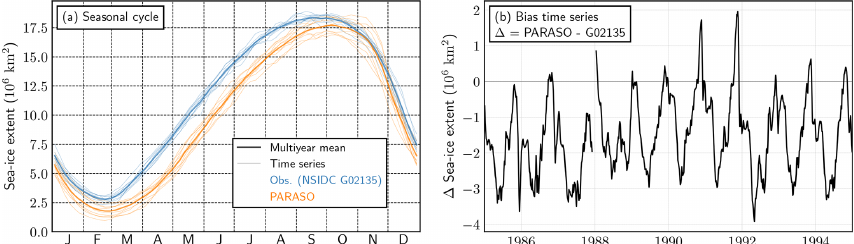
Figure A10. Antarctic sea-ice extent from observations (NSIDC-G02135, Fetterer et al., 2017) and from an additional fully coupled PARASO experiment (not presented here) covering the 1985–1994 period: (a) seasonal cycle and (b) bias time series (PARASO–NSIDC-G02135). In panel (b) , the gap around 1988 is due to a shortage in observational